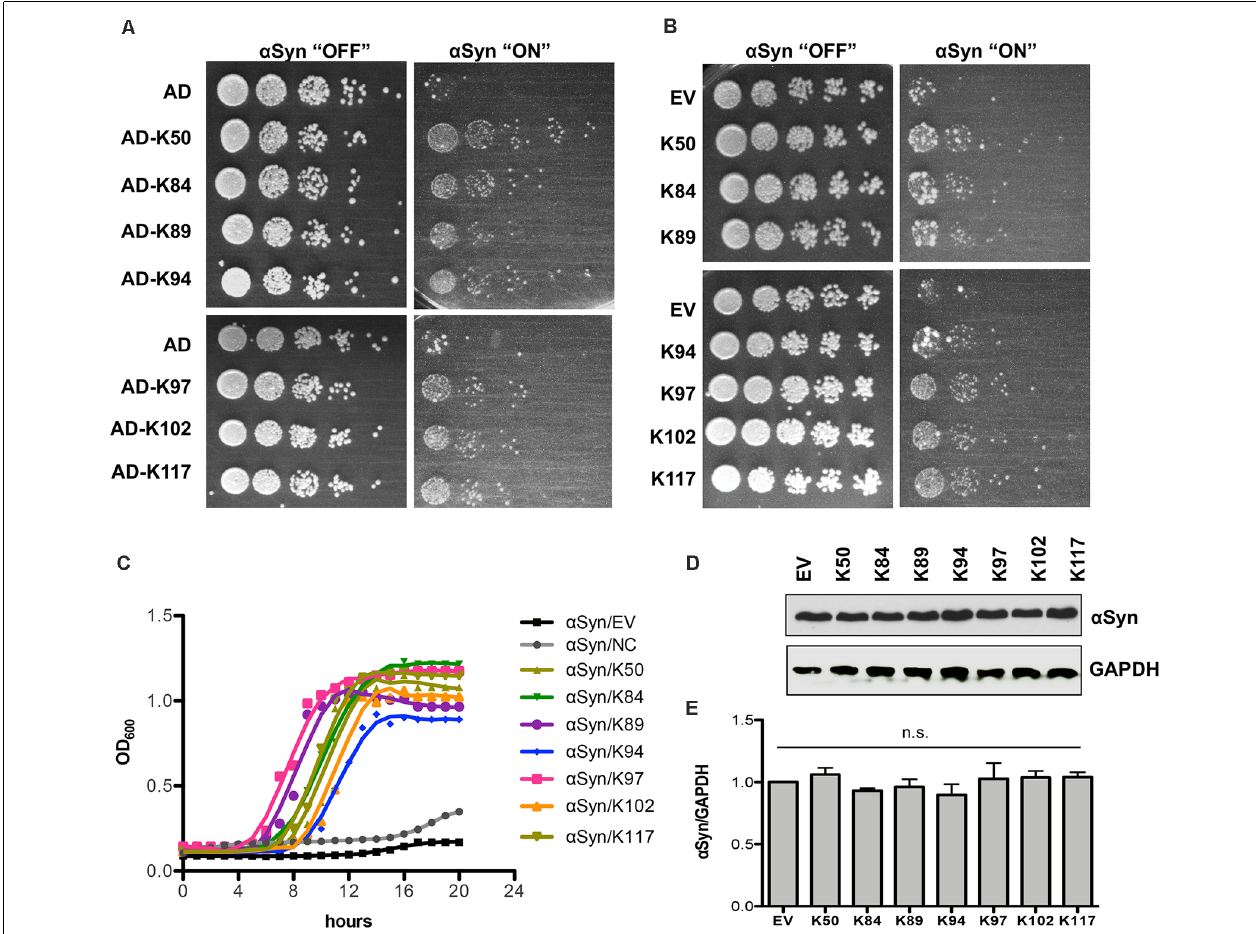
FIGURE 1 | Expression of seven peptide constructs reduces α Syn-induced growth inhibition. (A) The yeast strain that harbors three copies of GAL1 -driven α Syn-GFP-encoding gene (inducible “high-tox” strain RH3468) was transformed with the plasmid constructs, isolated from the screen. The Y2H plasmids contain the peptide-encoding sequence, fused to the B42-activation domain (AD). Yeast cells were spotted in 10-fold dilution on SC-Leu-Ura selective plates containing glucose (control: α Syn “OFF”) or galactose ( α Syn “ON”) for induction of GAL1 promoter. Plasmid with AD was used as a control. Images of the plates were captured on the third day. (B) The peptide-encoding sequences were re-cloned without the N-terminal activation domain and driven by the GPD promoter. The yeast high-tox strain was transformed with the corresponding plasmids and spotting assays were performed. Empty vector (EV) was used as a control. (C) Growth analyses of yeast cells from (B) in galactose-containing medium for 20 h. (D) Immunoblotting analysis of protein crude extracts of yeast cells from (B) after 6 h induction in galactose-containing medium with an anti- α Syn antibody. Anti-GAPDH antibody was used as a loading control. (E) Densitometric analysis of the immunodetection of α Syn-GFP, relative to the loading control GAPDH. n.s.: not significant, ( n = 3).